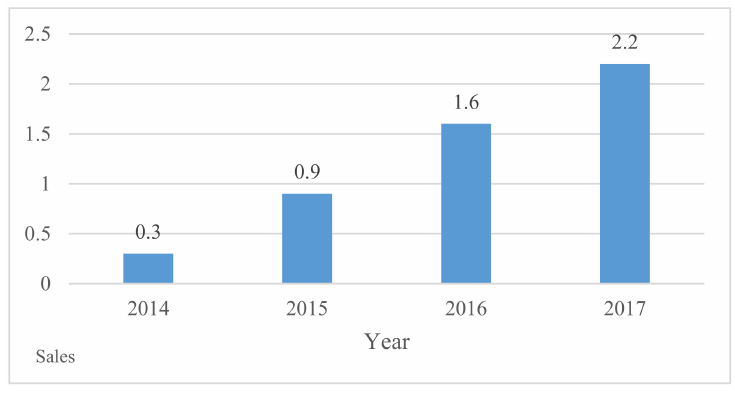
Figure 6. Sales of Coupang (USD). Source: Fortunekorea(2019)